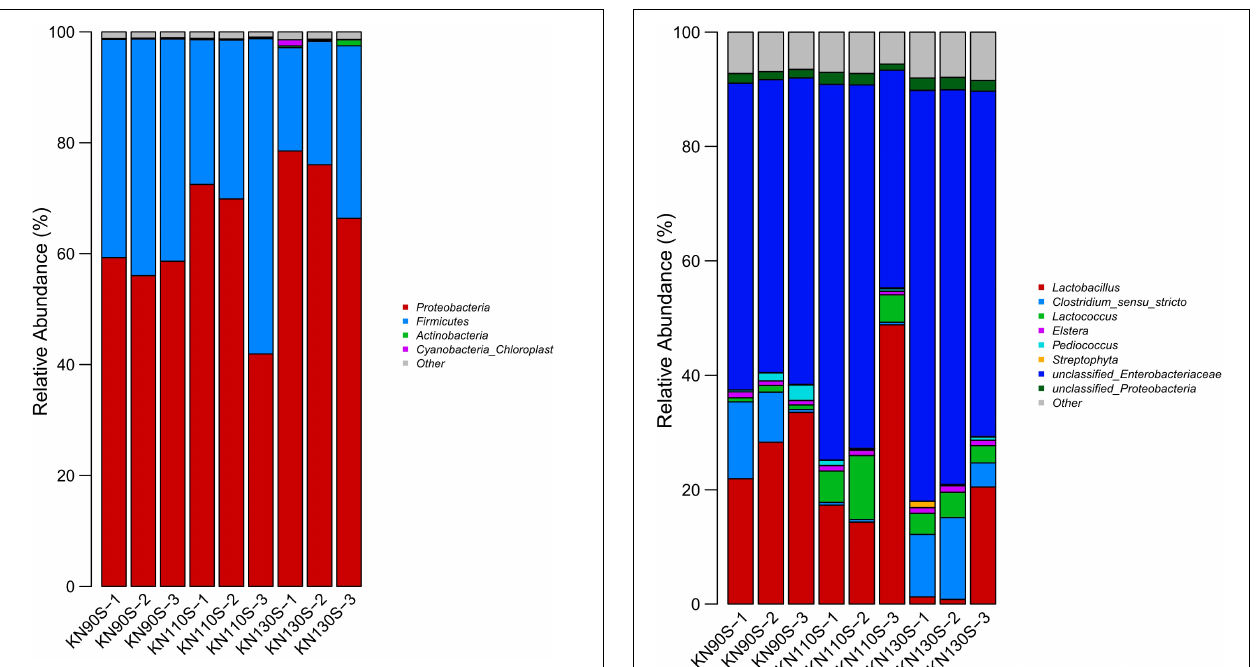
by Wang et al. (2020) in Italian ryegrass silages. Savoie et